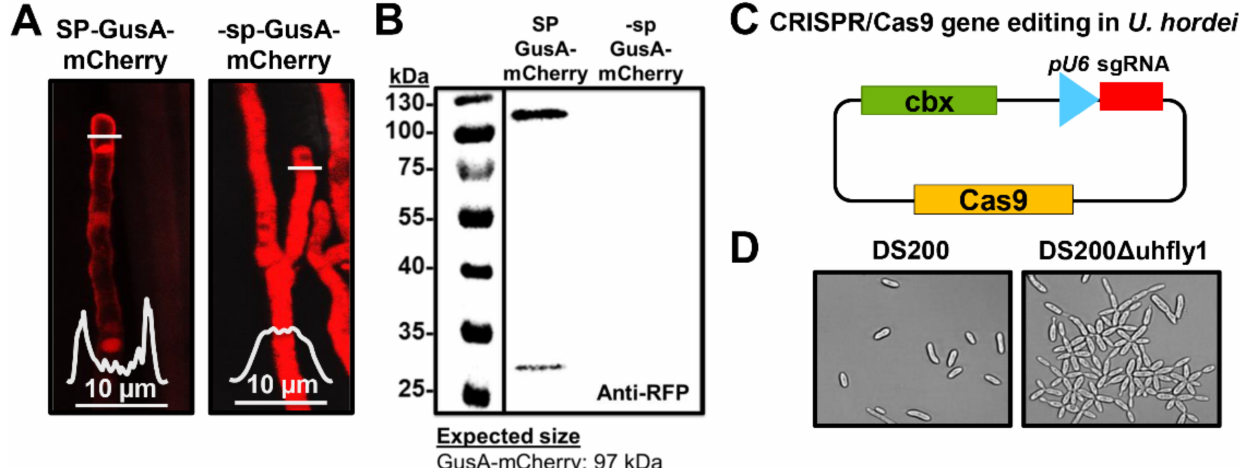
Figure 3. ( A , B ) Heterologous expression of GusA-mCherry in Ustilago hordei . ( A ) GusA-mCherry was heterologously expressed in solopathogenic strain DS200 under control of the UHOR_02700 promotor with or without signal peptide (SP) for extracellular secretion. The ± SP-GusA-mCherry DS200 strains were inoculated on barley seedlings, then at 4 days post inoculation (dpi) confocal microscopy was performed to monitor expression and localization of recombinant proteins. While +SP-GusA-mCherry is secreted around the tip of the invasive hyphae, -sp-GusA-mCherry localizes in the fungal cytoplasm. The white graphs indicate the mCherry signal intensity along the diameter of the hyphae (illustrated by white lines in the image). ( B ) Western blot analysis was performed with apoplastic fluid isolated from barley leaves infected with ± SP-GusA-mCherry DS200 strains. While a band corresponding to secreted +SP-GusA-mCherry (at ~100 kDa) and free mCherry (at 27 kDa) in isolated apoplastic fluid was detected, no band corresponding to cytoplasmic -sp-GusA-mCherry could be detected. Anti-RFP antibody was used for Western blot analysis. ( C , D ) Establishment of CRISPR/Cas9 gene editing system for Ustilago hordei . ( C ) Codon-optimized Cas9 was cloned into the p123 plasmid under the control of the Hsp70 promoter. The U. hordei pU6 promotor was used to express sgRNA for the targeted gene. Carboxin resistance was used as selection marker. ( D ) U. hordei Fly1 gene, a fungalysin metalloprotease involved in fungal cell separation, was edited via the CRISPR/Cas9 system for knock-out. While DS200 sporidia showed normal growth, DS200 ∆ uhfly1 cells were impaired in cell